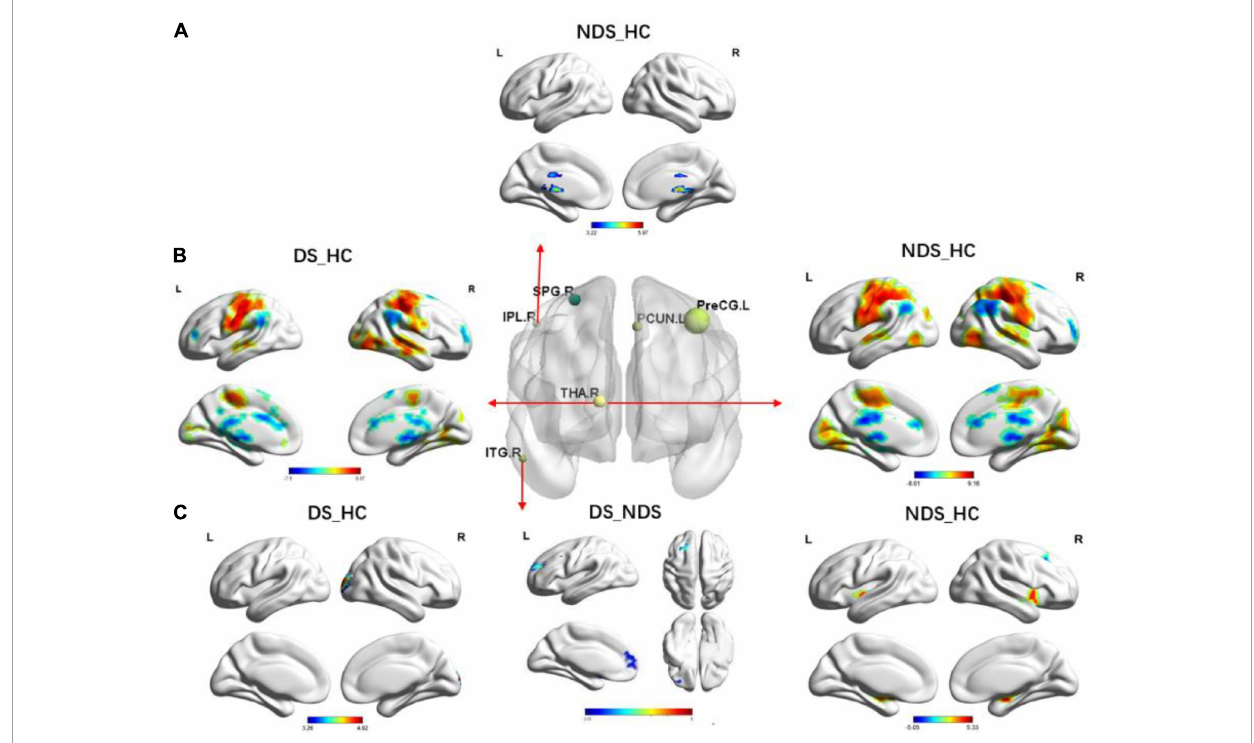
FIGURE3 Group comparisons of functional connectivity (FC) in six region of interests (ROIs) among deficit schizophrenia (DS), non-deficient schizophrenia (NDS), and health controls (HC). (A) Group analyses of the FC in the right inferior parietal lobule between NDS and HC groups. The significance threshold was set at p < 0.05 after false discovery rate (FDR) was corrected (voxel p < 0.05, cluster size ≥ 146). (B) Group analyses of the FC in the right thalamus between patients and HC groups. The significance threshold was set at p ≤ 0.05 after FDR was corrected (voxel p < 0.05, cluster size ≥ 200). (C) Group analyses of the FC in the right inferior temporal gyrus between patients and HC groups. The significance threshold was set at p < 0.05 after FDR was corrected (voxel p < 0.05, cluster size ≥ 162/100/100). The blue regions indicate the regions where patients had lower FC compared to HC; the red areas show the regions where patients had greater FC compared to HC, when DS vs. NDS, and the blue regions indicate the regions where DS had lower FC compared to NDS. IPL.R, right inferior parietal lobule; THA.R, right thalamus; ITG.R, right inferior temporal gyrus; FC, functional